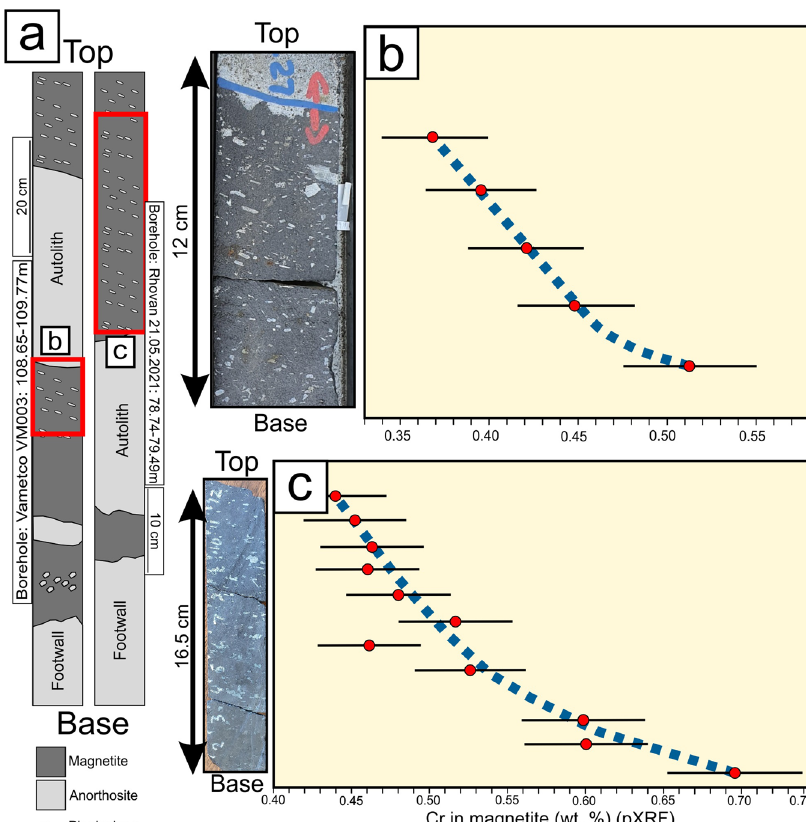
Fig. 4 Cr in magnetite analyzed across two portions of the bottom seam from the Vametco mine in the Western Limb that contain plagioclase primocrysts. Sections were analyzed using a portable XRF spectrometer ( “ Methods ” ). a Sketches of drill cores with the sections analyzed are highlighted in red. The light-colored anorthositic footwall is shown in both examples and is overlain by dark magnetitite. Both examples contain light- colored anorthositic autoliths. In b , c the distribution of Cr in magnetite is shown across sections containing non-cotectic portions of magnetite and plagioclase. A steep, but regular upward depletion is observed in both cases. Horizontal lines indicate 2 Θ error bars on both b , c . Blue lines are fi t by hand to highlight the trend of Cr